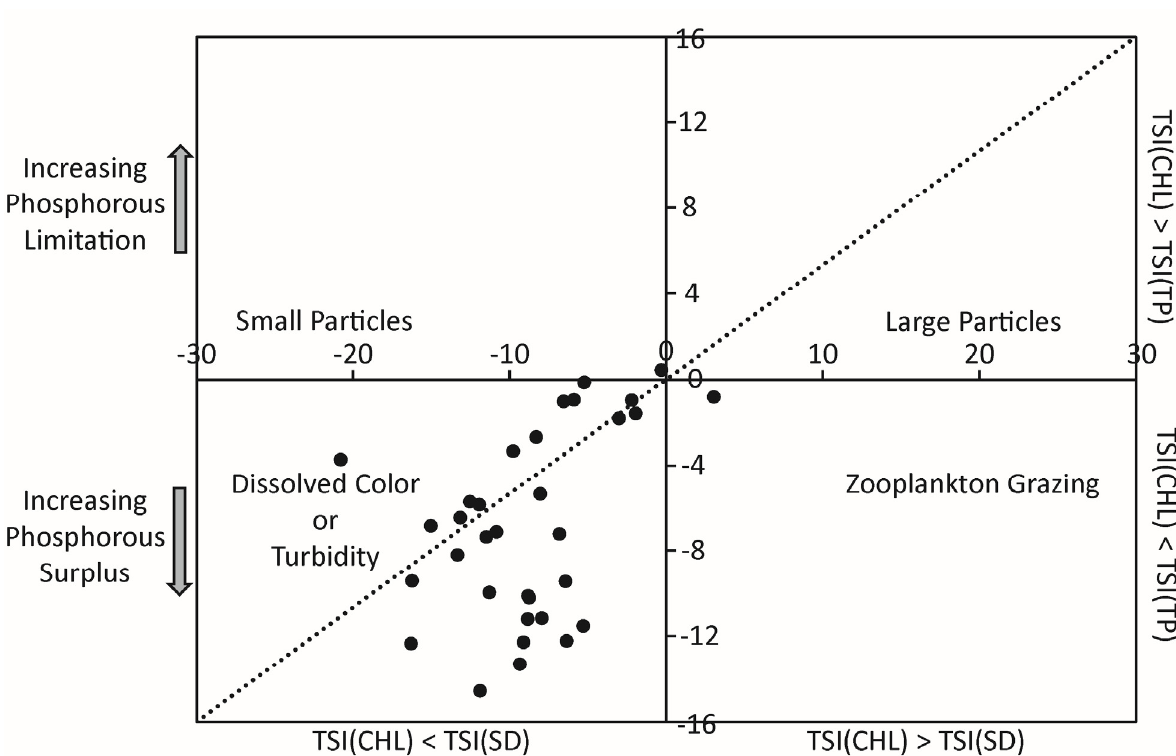
Figure 9. Illustration of possible causes of deviations between the trophic state indices (TSI) derived from chlorophyll a concentrations, Secchi depth and total phosphorous